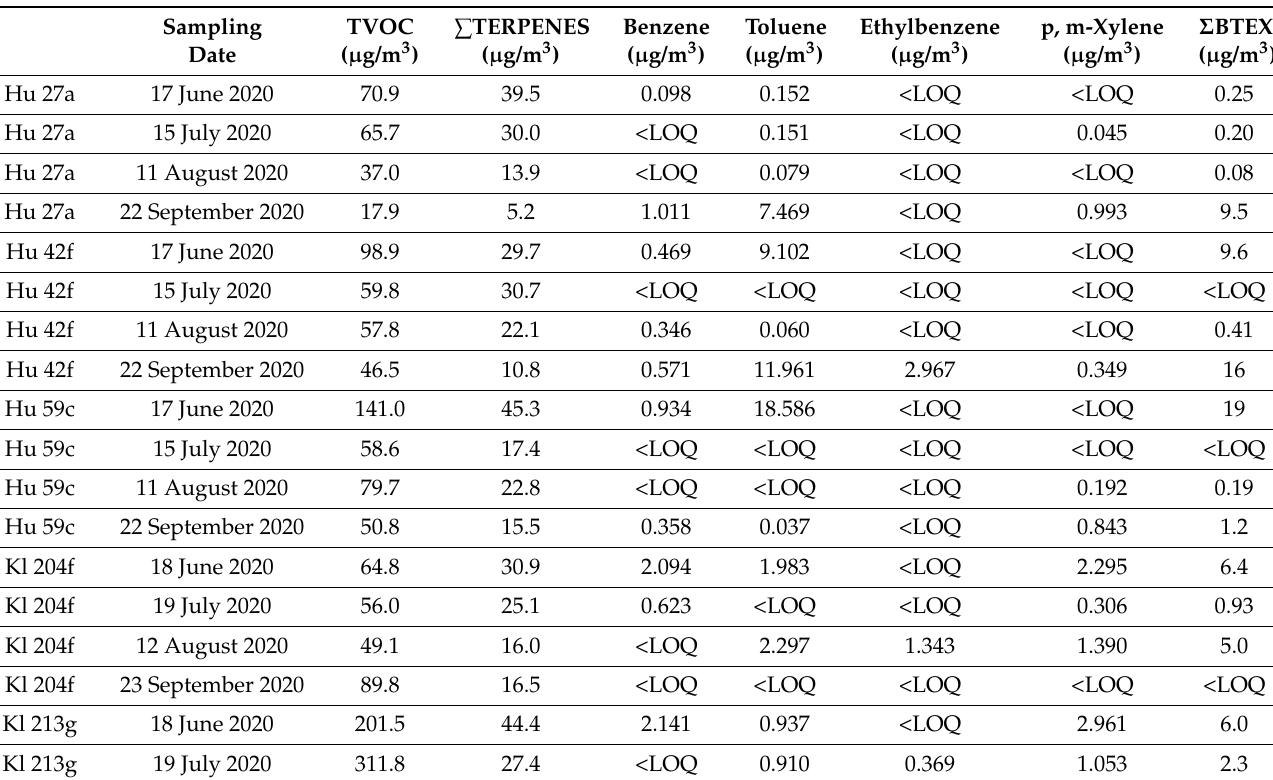
(a) RI values of essential oil components for GC HP-5 MS column based on literature data from Bottoni et al. [55] and Khan et al. [56]. Table 4. Concentrations of selected organic compounds determined in samples collected during all sampling campaigns in the forest atmosphere: (i) TVOC—sum of concentrations of all VOC present in the sample; (ii) concentration of BTEX compounds and the sum of BTEX compounds; (iii) the sum of identified